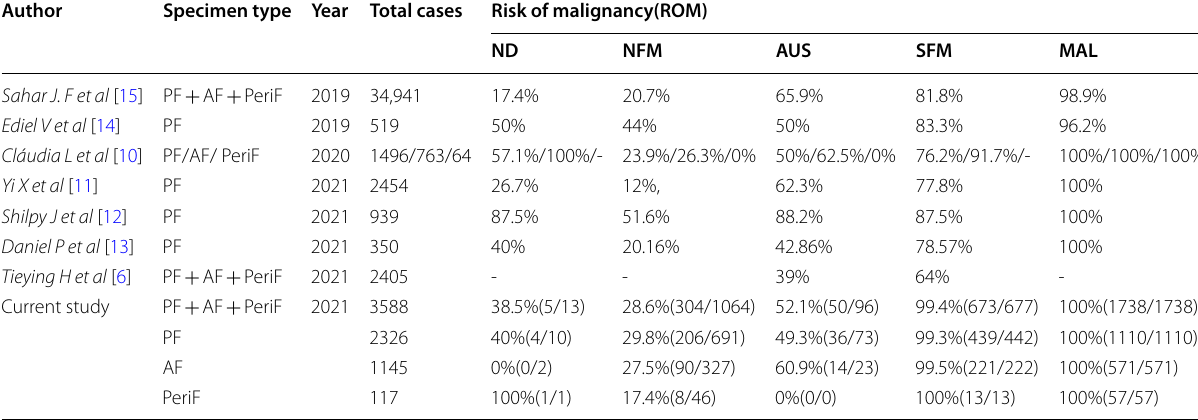
Abbreviations: ND non-diagnostic, NFM negative for malignancy, AUS atypia of undetermined significance, SFM suspicious of malignancy, MAL malignancy, PF pleural fluid, AF ascitic fluid, PeriF pericardial fluid